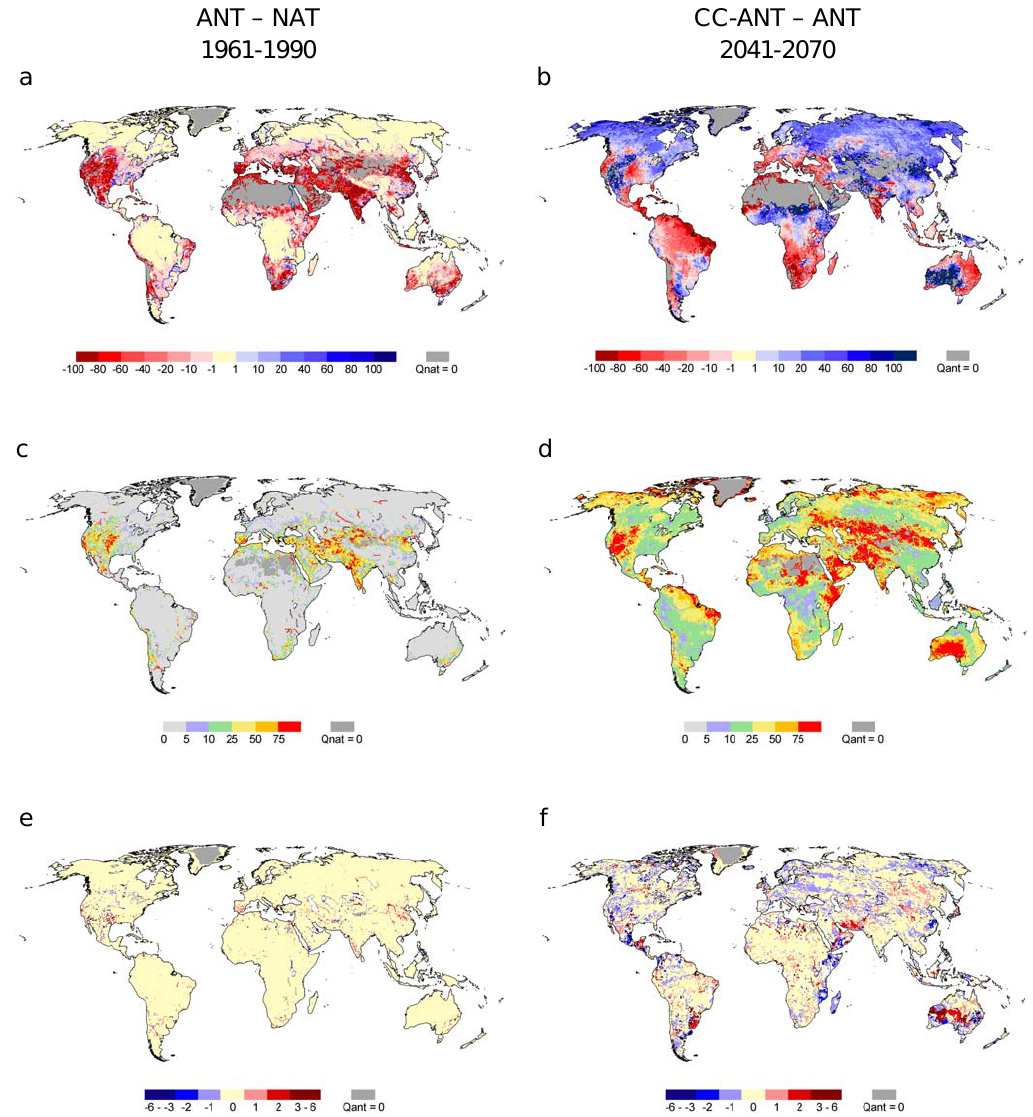
Fig. 4. Comparison of the impact of climate change to the impact of dams and water withdrawals. Impact of dams and withdrawals on naturalized discharge (ANT – NAT, in % of NAT), for monthly low flows Q 90 , I LF (a) , seasonal flow regimes, I SR (c) , and shift of the month with maximum flow, I TS (e) , as compared to impacts of climate change on anthropogenically altered discharge (CC-ANT – ANT, in % of ANT), for monthly low flows Q 90 (b) , seasonal flow regimes (d) , and shift of the month with maximum flow (f) . Dams and withdrawals in the year 2002, climate change between 1961–1990 and 2041–2070 according to the emissions scenario A2 as implemented by the global climate model